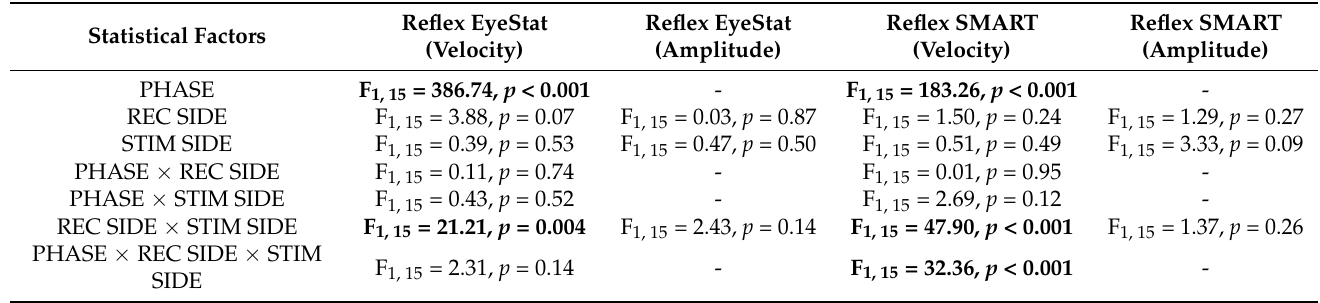
Table 5. Statistical analysis for the EyeStat device and SMART system recordings (reflex blink- ing). The table shows the statistical output from the rmANOVA performed on the EyeStat device and SMART system on the reflex blinking data. PHASE: blinking phase; REC SIDE: recording side; STIM SIDE: stimulation side. Significant factors and interactions are depicted in